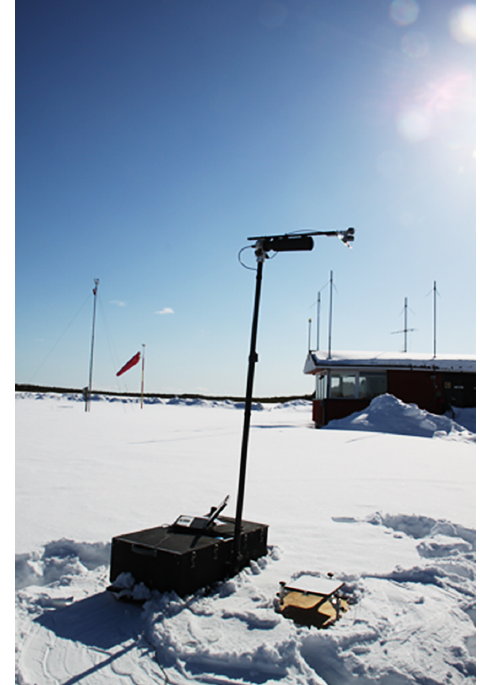
Figure 2. FIGIFIGO at the SoS test site at Sodankylä Airport. A clean snow sample has been measured, and the last reference measurement of the white Spectralon ® panel is being taken. Deep and soft snow complicated the usability of FIGIFIGO. While the movements in the snow left significant traces, the target area under the instrument footprint was carefully kept untouched during the